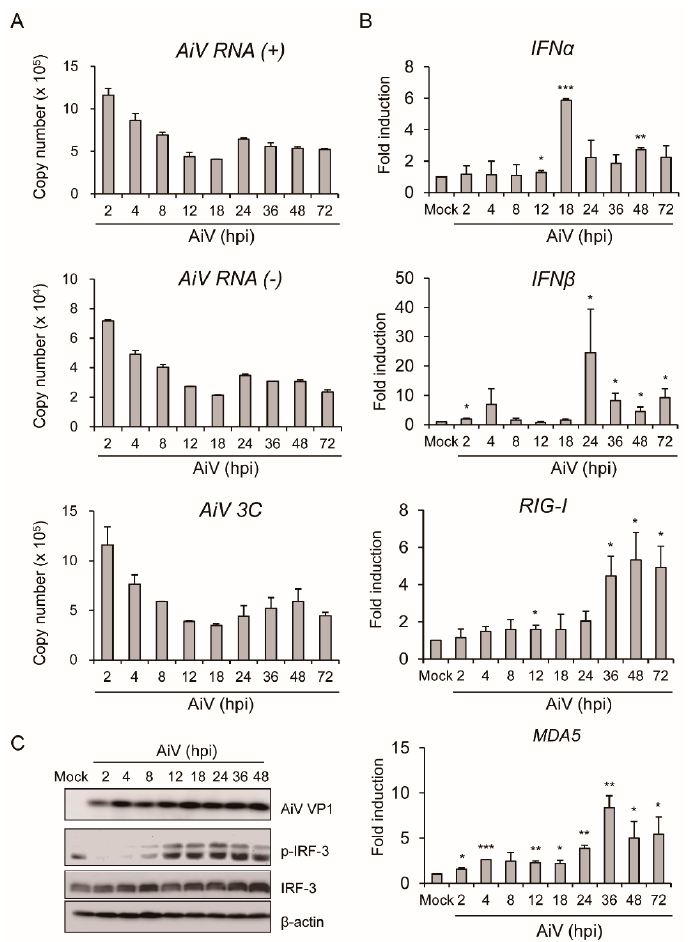
Figure 6. AiV activates type I IFN activity in T84 cells. ( A ) T84 (1 × 10 5 ) cells infected with AiV at